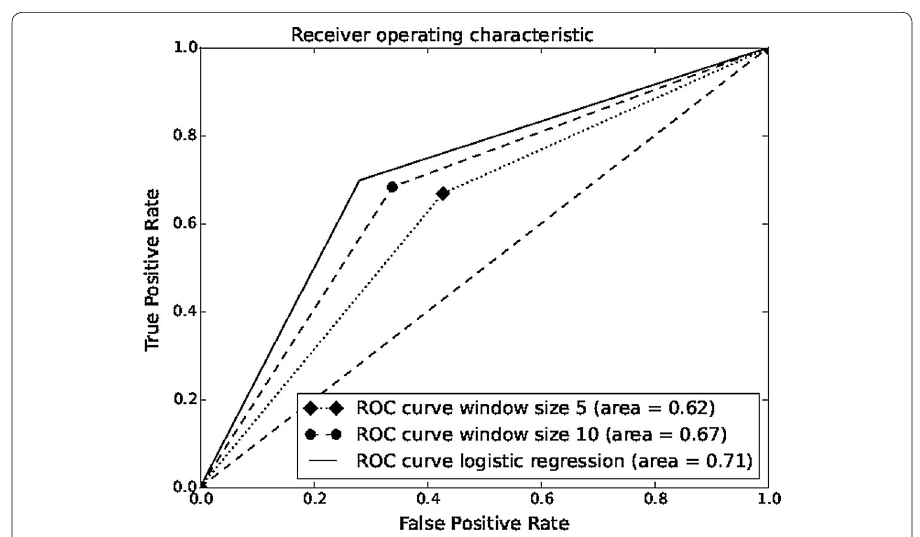
Fig. 5 Area under the ROC curve for doc2vec with window size of 5 and 10